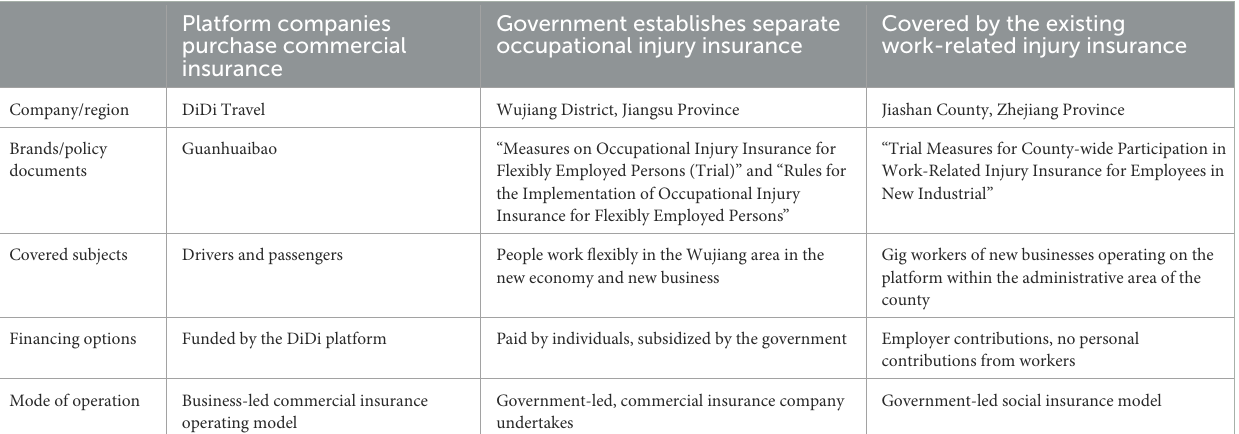
TABLE 1 Ways to achieve work injury protection for gig